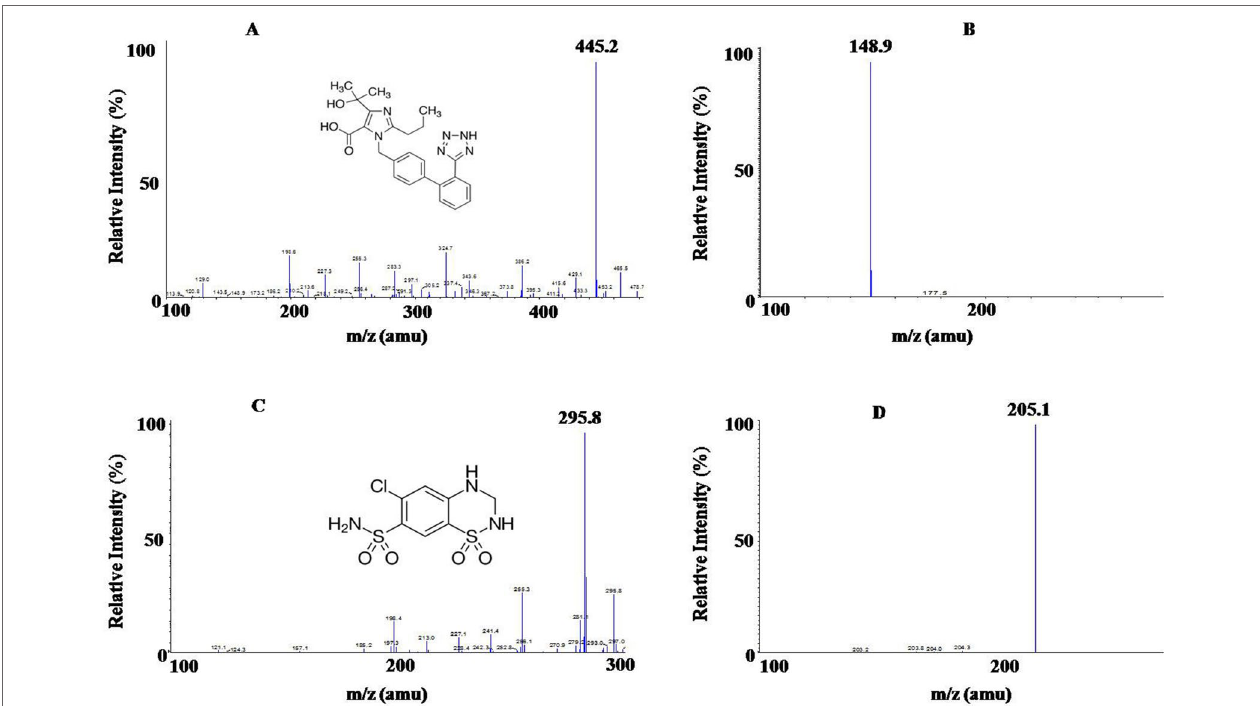
FIGURE 1 | (A) Molecular structure of Olmesartan (OLM) OLM with parent ion scan m/z 445.2 amu and (B) product ion scan m/z 148.9 amu; (C) Molecular structure of hydrochlorothiazide (HCTZ) with parent ion scan m/z 295.8 amu, (D) product ion scan m/z 205.1